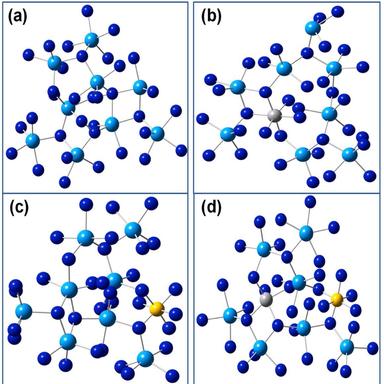
The optimized structure models of (a) Ta3N5, (b) V-doped Ta3N5, (c) S-doped Ta3N5, and V@S-codoped Ta3N5.